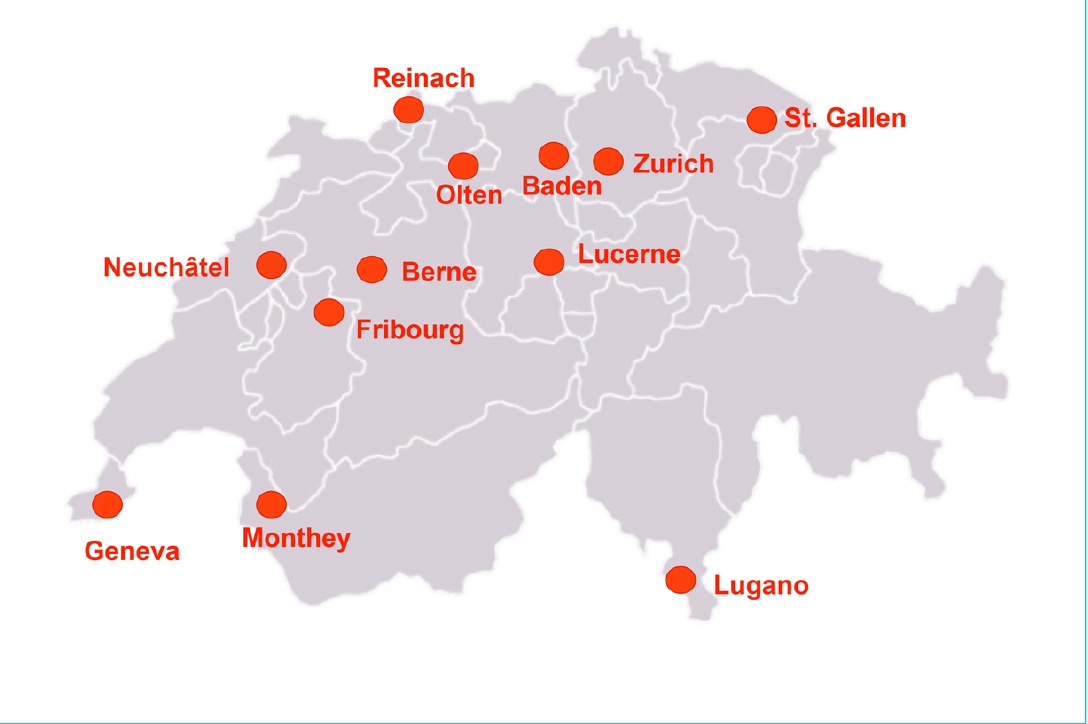
Figure S1: Geographical distribution of the medical centres that responded to the survey.The geographical locations of the twelve medical centres and hospitals responding to the survey are